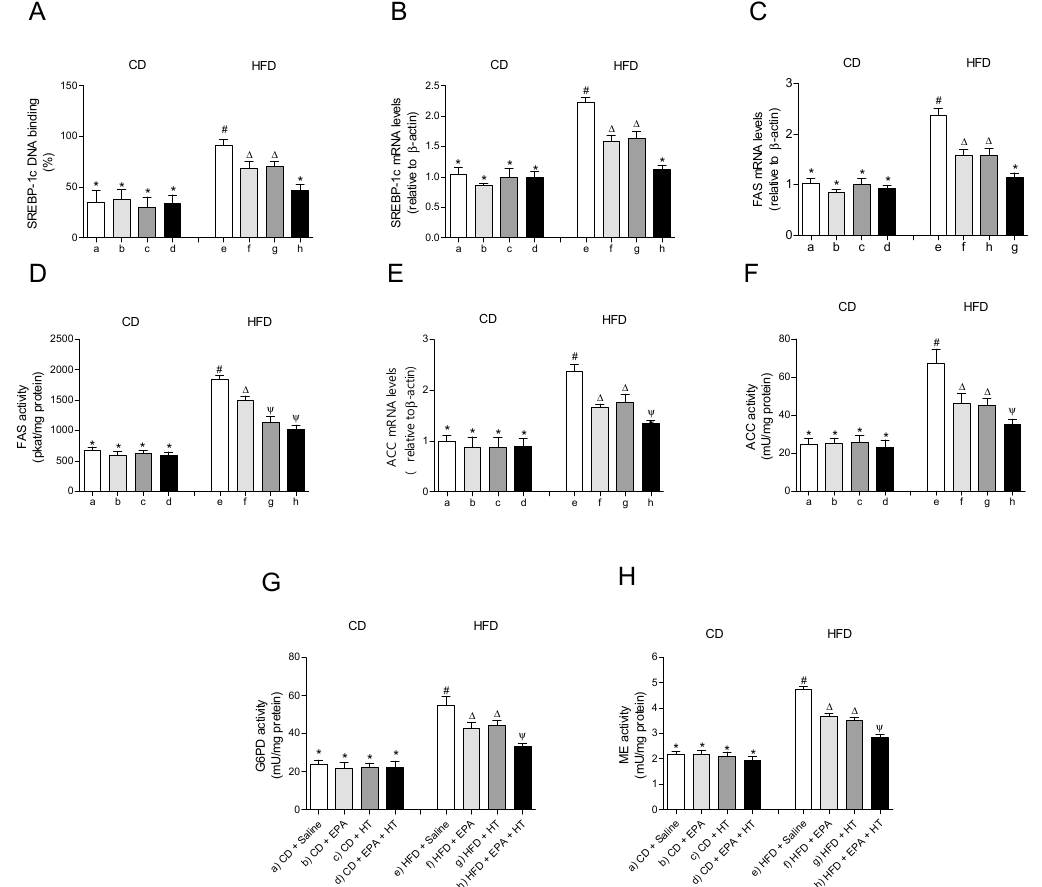
Figure 3. Sterol regulatory element-binding protein-1c (SREBP-1c) DNA-binding, ( A ) SREBP-1 mRNA levels, ( B ) fatty acid synthase (FAS) mRNA content, ( C ) FAS activity, ( D ) acetyl-CoA carboxylase (ACC) mRNA levels, ( E ) ACC activity, ( F ) glucose-6-phosphate dehydrogenase (G6PD) activity, ( G ) and malic enzyme (ME) activity ( H ) in epididymal white adipose tissue from mice subjected to control diet (CD) and high-fat diet (HFD) supplemented or not with eicosapentaenoic acid (EPA), hydroxytyrosol (HT) or EPA + HT. Values are expressed as mean ± SD. Eight to ten mice were included in each experimental group. Groups that do not share the same superscript symbol were significantly di ff erent among them, namely, (a), CD + saline; (b) CD + EPA; (c) CD + HT; (d) CD + EPA + HT; (e), HFD + saline; (f) HFD + EPA, (g) HFD + HT; and (h), HFD + EPA + HT, according to two-way analysis of variance (ANOVA) followed by the Tukey’s post-test, p < 0.05. ( * ), does not di ff er from (a) group; ( # ), di ff er from (a) group; ( ∆ ), di ff er from (a) and (e) groups; ( Ψ ), di ff ers from groups (a), (e) and those marked with the symbol ∆